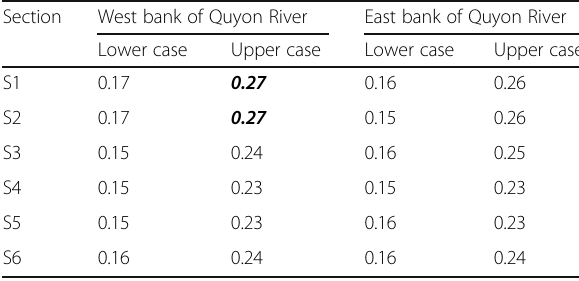
Table 2 Threshold horizontal ground accelerations (g) of lateral sections of Quyon landslide